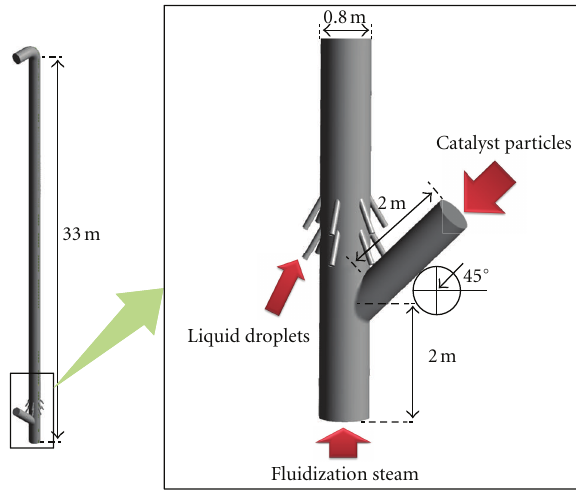
Figure 2: Geometry of the industrial